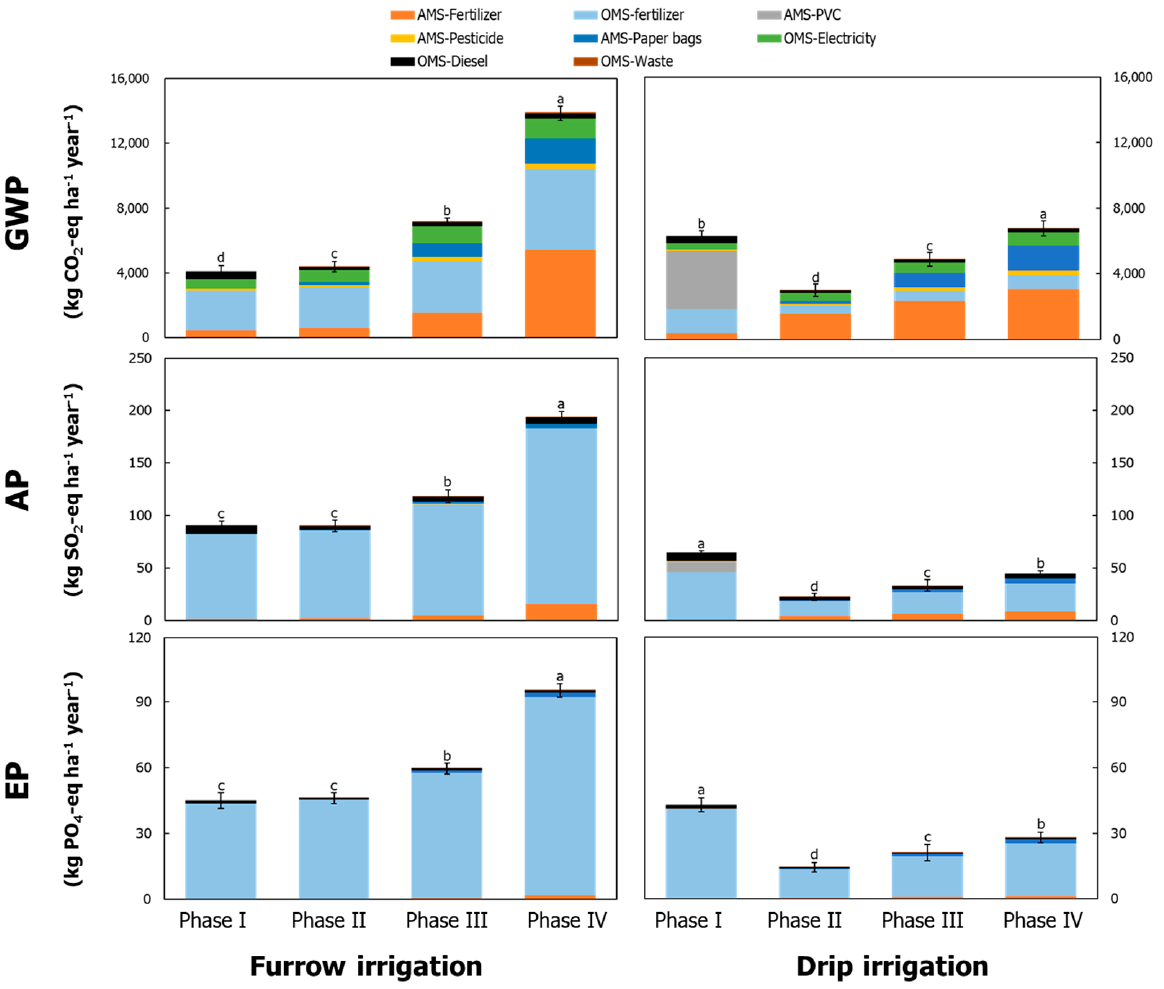
Figure 3. Annual GWP, AP, and EP expressed per hectare of furrow and drip irrigated pear production system in different phases. Phase I–IV represent the orchard installation phase, the primary growing phase, the low production phase, and the full production phase, respectively. AMS and OMS are the abbreviation of the agriculture materials input stage and orchard management stage, respectively. Different letters represent significant differences ( p < 0.05) among the phases (a, b, c, and d).